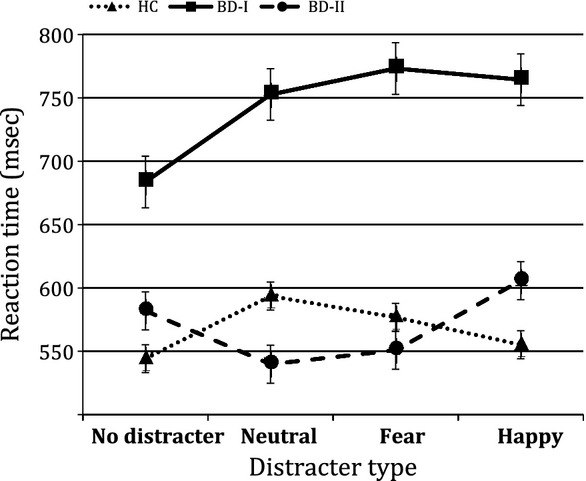
Reaction time to the 2-back targets during the presentation of different emotional distracters. Error bars correspond to the standard error of the mean. BD-I = bipolar I disorder; BD-II = bipolar II disorder; HC = healthy controls.